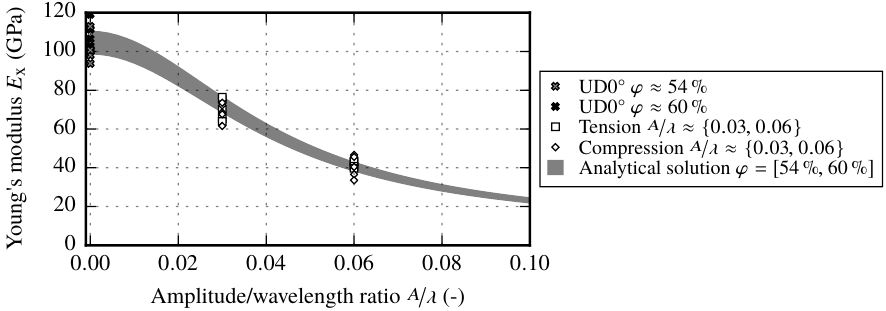
Figure 25. Comparison of the experimental results to the range of the analytical solution for the effective material stiffness E x in fiber direction, depending on the imposed amplitude to wavelength ratio.